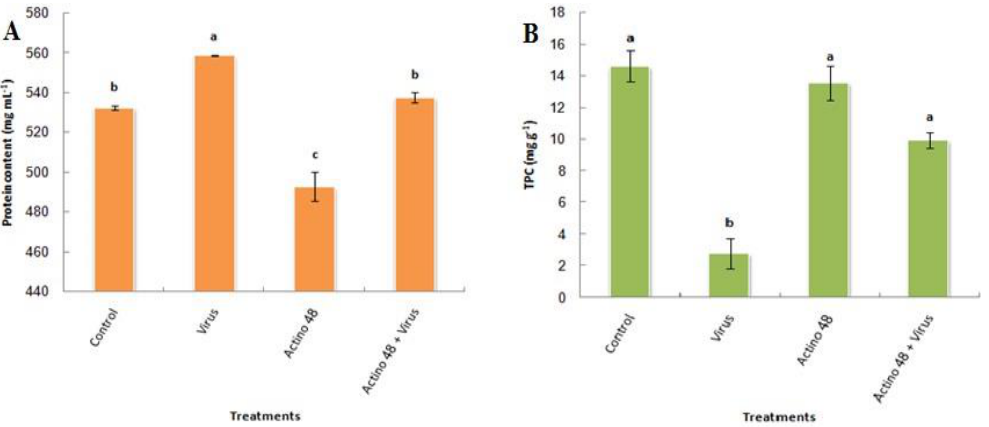
Figure 3. Effect of Streptomyces cellulosae isolate Actino 48 on the ( A ) protein content and ( B ) total phenolic compounds in tomato leaves at 21 days post-inoculation. Columns with the same letter denote insignificant differences.